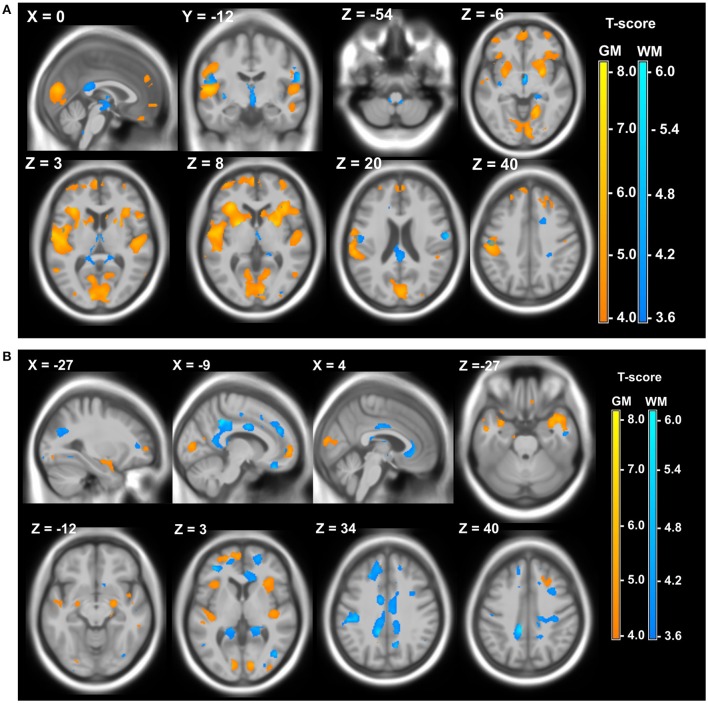
Local atrophy of gray matter (GM) and white matter (WM) in DM patients. (A) Local atrophy of GM (yellow) and WM (blue) in 12 DM1 patients compared to 28 healthy controls. (B) Local atrophy of GM (yellow) and WM (blue) in 15 DM2 patients compared to 28 healthy controls. Voxelwise multiple regression analysis with group and age as covariates. Age was used as a covariate of no interest. Areas with adjusted p at cluster level <0.05 after FWE correction are shown; X, Y, Z: MNI-coordinates: negative X-values reflect left side and positive X-values right sided location. Adapted from Schneider-Gold et al. (2015).